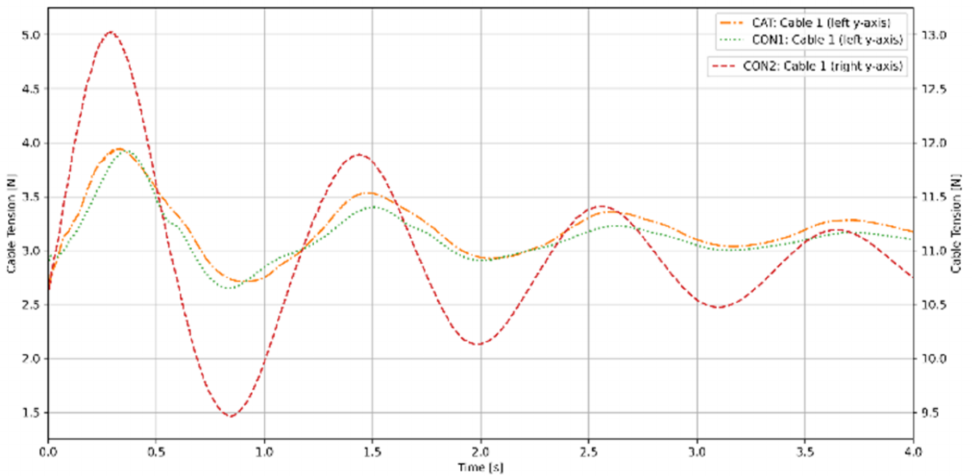
Figure 11. Comparative time series of mooring line tension obtained from decay tests in heave for the buoy with mooring systems CAT, CON1, and CON2.